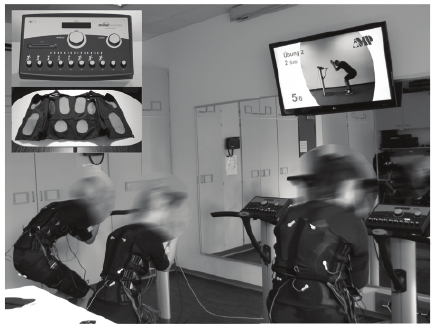
Figure 2: Whole-body electromyostimulation equipment.